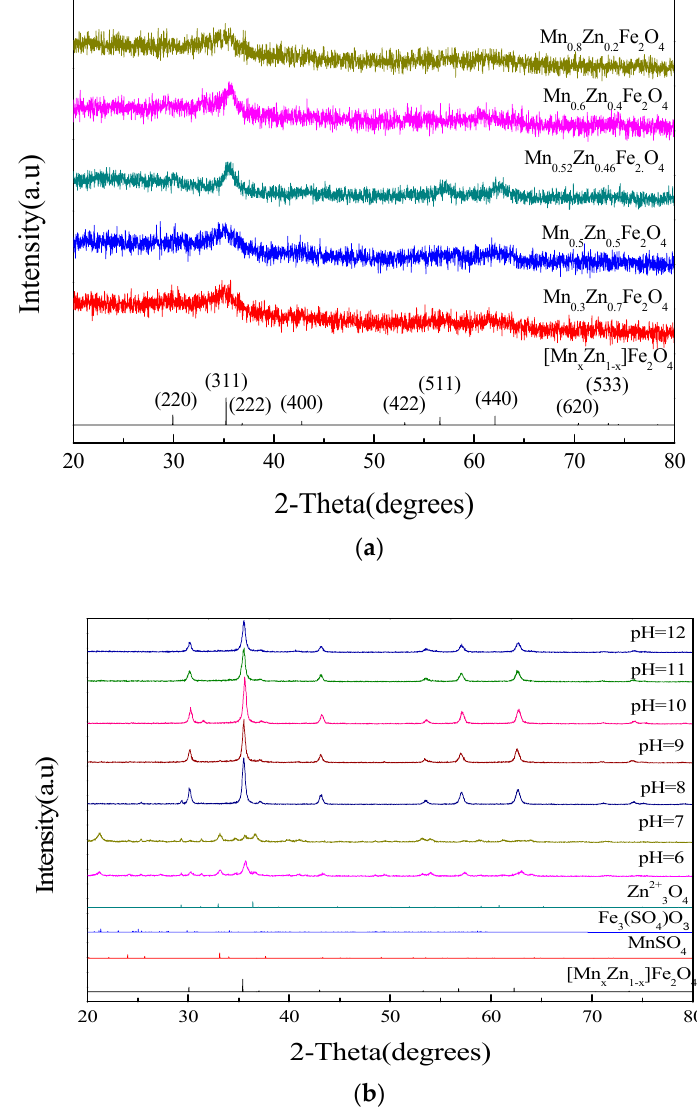
Figure 2. XRD patterns for ( a ) [Mn x Zn 1 − x ]Fe 2 O 4 sintered at 600 °C and ( b ) the effect of the pH value of the waste dry battery.